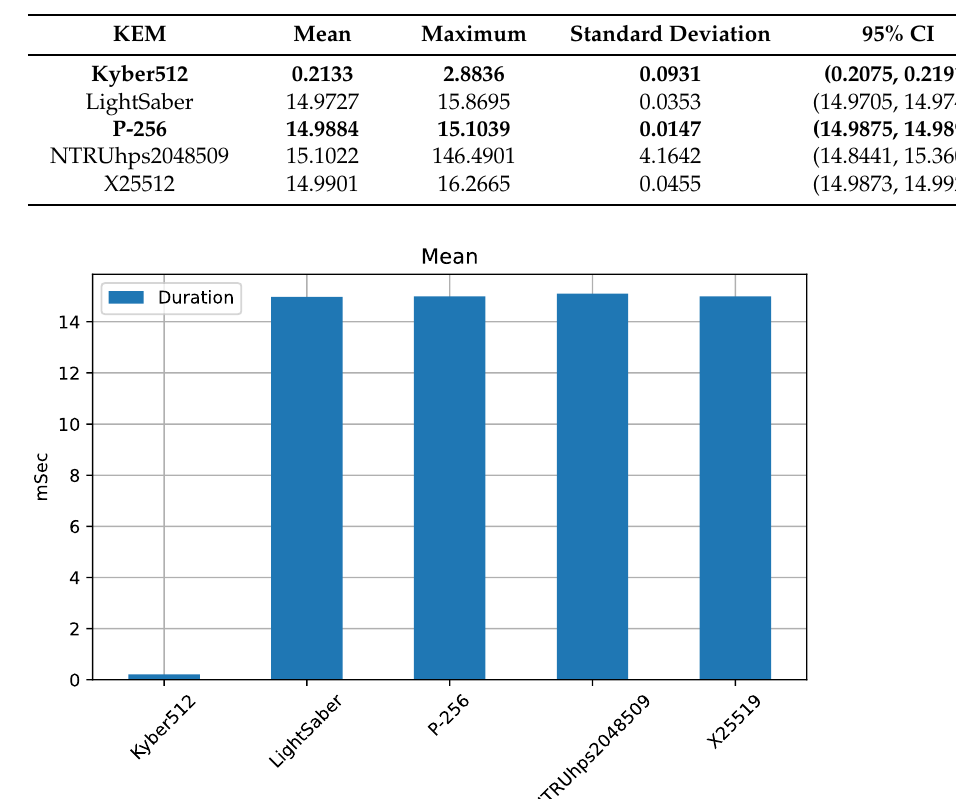
Figure 9. The mean value of the connection is almost the same for all the KEMS, with an average of a little more, of 14 ms. The minimum value is achieved by Kyber512, with less than 2 ms. In Table 10, we show the 95% CI for the connection